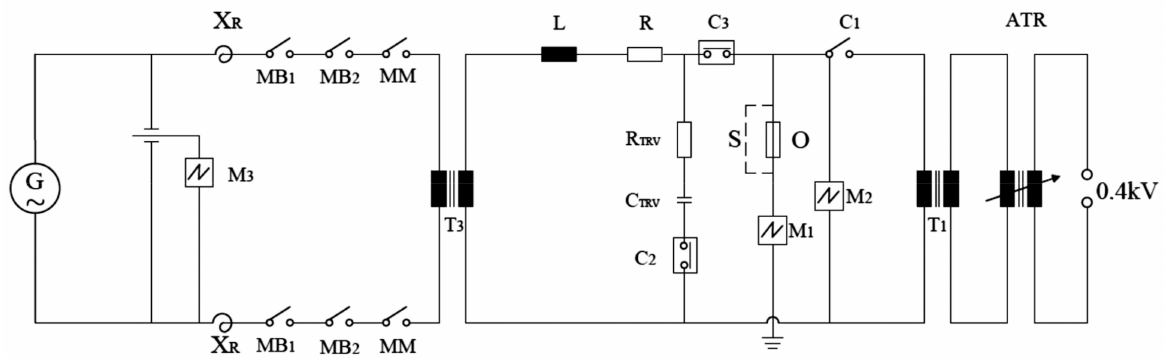
Figure 2. Test circuit for test series I 3